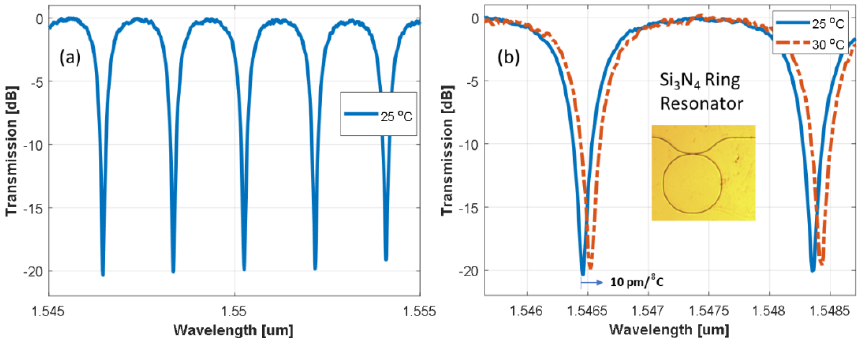
Table 1. Summary of the results of SiOC-coated Si 3 N 4 and pristine Si 3 N 4 ring resonators. Device Type